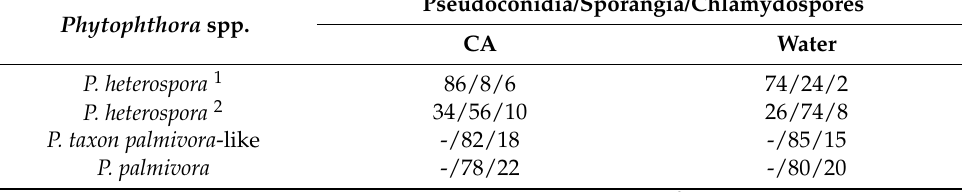
Table 2. Proportion (%) of pseudoconidia, sporangia, and chlamydospores produced by Phytophthora heterospora , P. taxon palmivora -like and P. palmivora at 20 ◦ C on solid carrot agar (CA) and on CA submerged in nonsterile soil extract